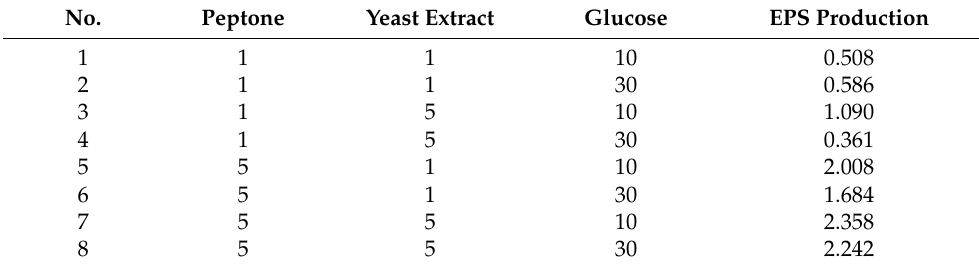
Table 1. Concentrations (g L − 1 ) of peptone, yeast extract and glucose used in the cultivation of BU-4 isolate in glucose-based medium. Production of EPS (g L − 1 ) is also presented. No. Peptone Yeast Extract Glucose EPS Production 1